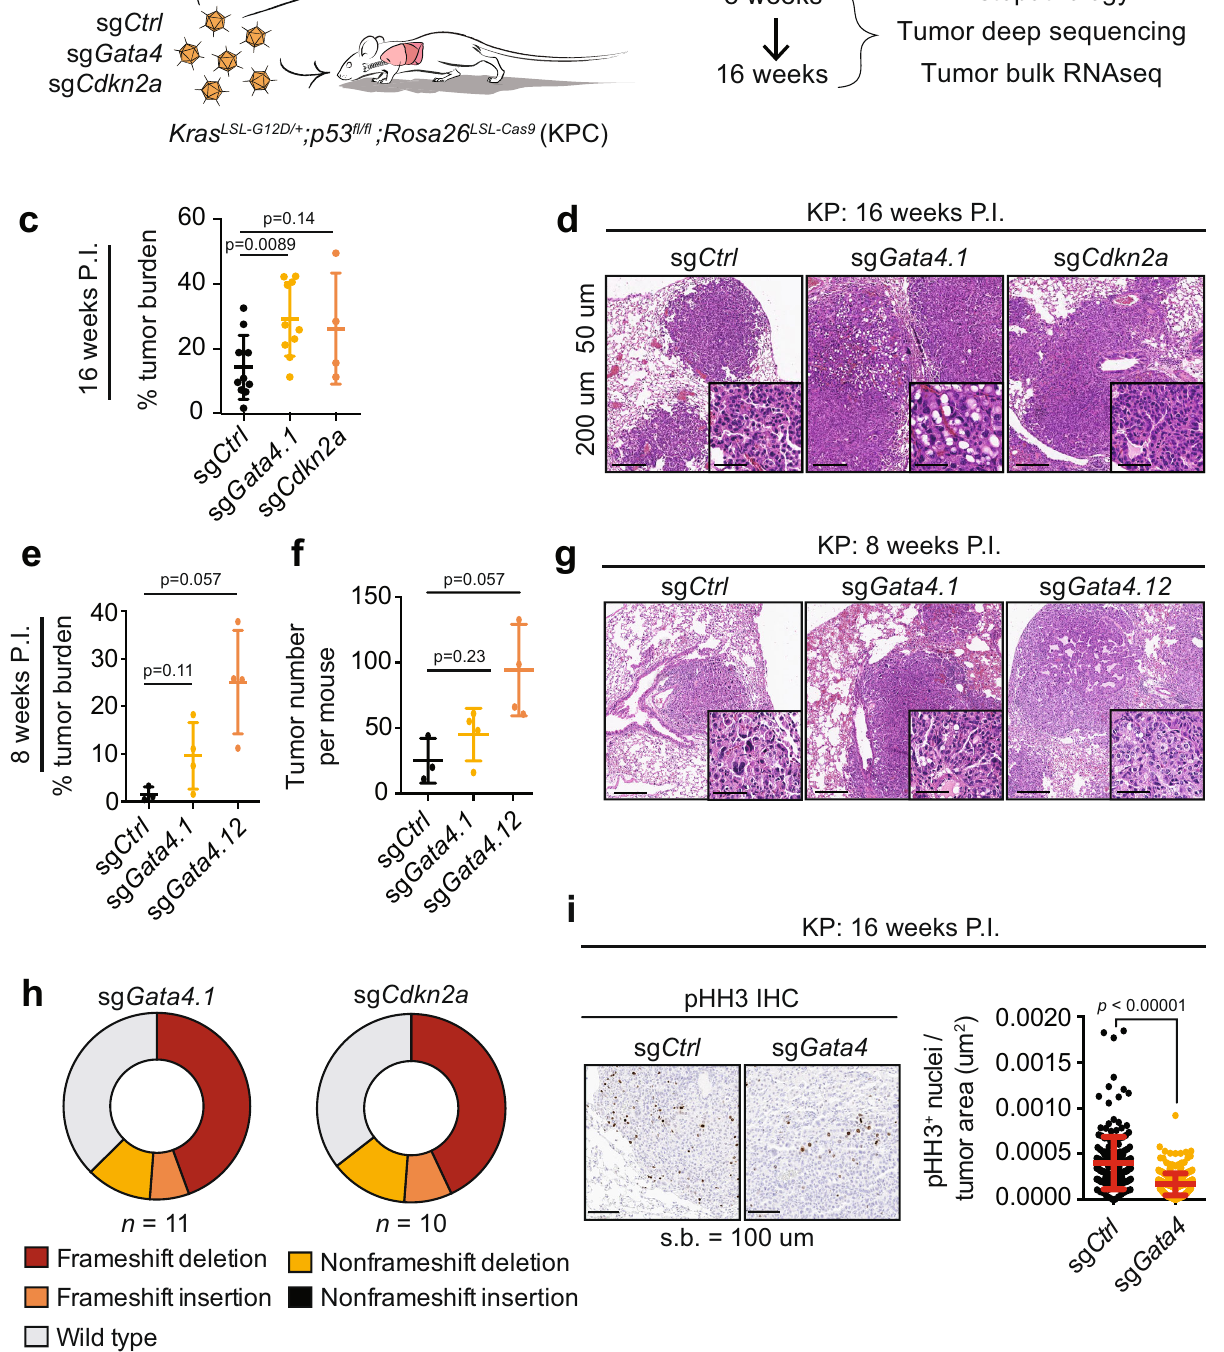
regulator Gata4 enhances tumorigenesis by increasing tumor initiation rather than by increasing cell proliferation. sg Gata4 -targeted tumors in the autochthonous model of lung adenocarcinoma have fewer TILs than control tumors . We interrogated the transcriptional consequences of CRISPR target- ing of Gata4 by performing RNA-seq on micro-dissected tumors